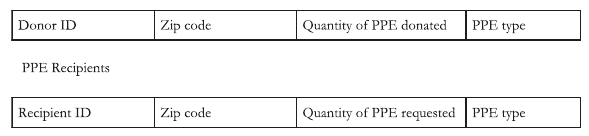
Fig. 3 Algorithm input data. Data collected from individuals offering to donate PPE “ donors ” and healthcare facilities requesting PPE “ recipients".